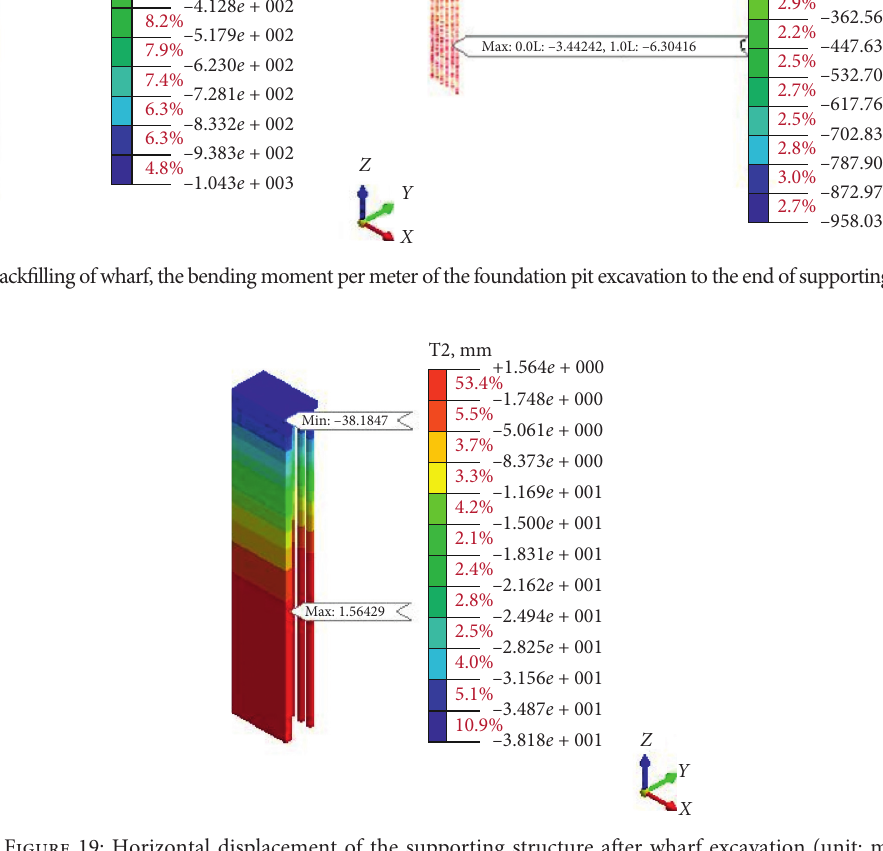
Figure 19: Horizontal displacement of the supporting structure after wharf excavation (unit: